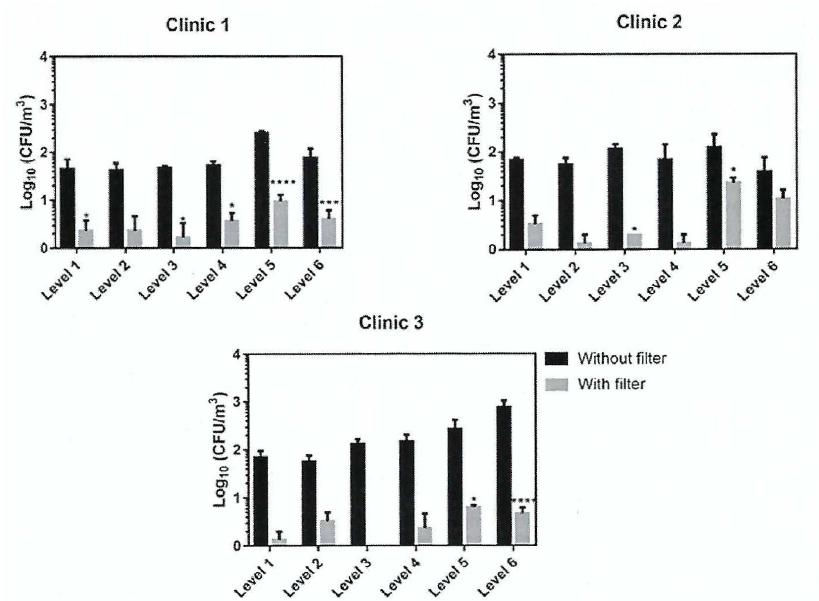
Figure 15. Differently sized bacteria (Level 1: huge (non-respirable); Level 6: small (respirable)) in three different dentistry clinics with and without air purifier. The stars refer to Sidak’s multiple comparisons test with *: p <0.01; ***: p <0.002; ****: p <0.0001. (Reprinted/adapted with permission from Ref.